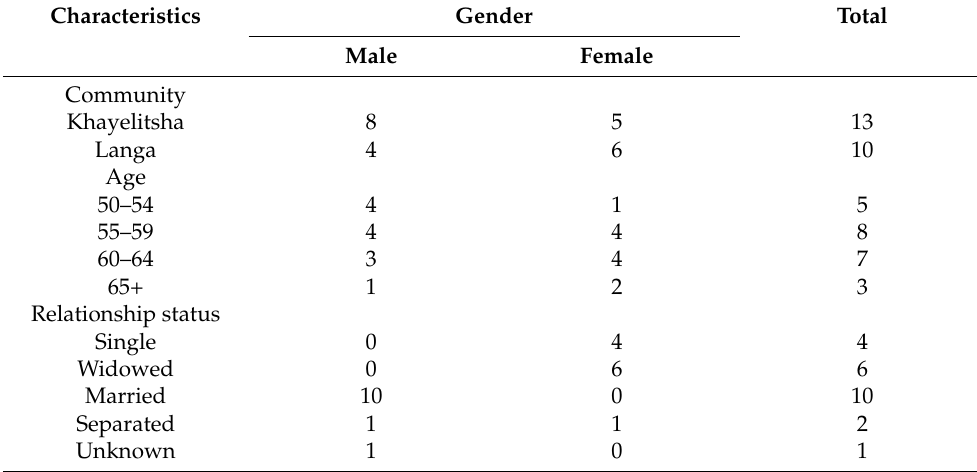
Table 1. Representation of study participants from the two sites by sex and age, n = 23.